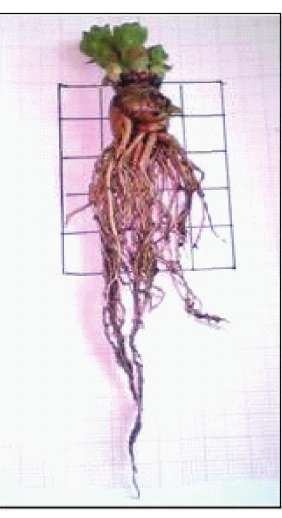
Figure 9: Roots and rhizomes of in vitro regenerated plant culti- vated two years in the green house [79].